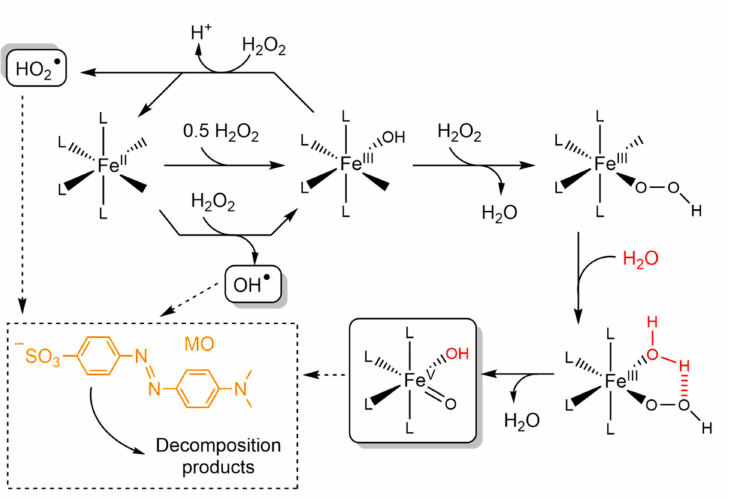
Figure 1. Mechanistic proposal for the catalytic activity of iron complexes towards the oxidation of organic compounds in the presence of H 2 O 2 . MO = methyl